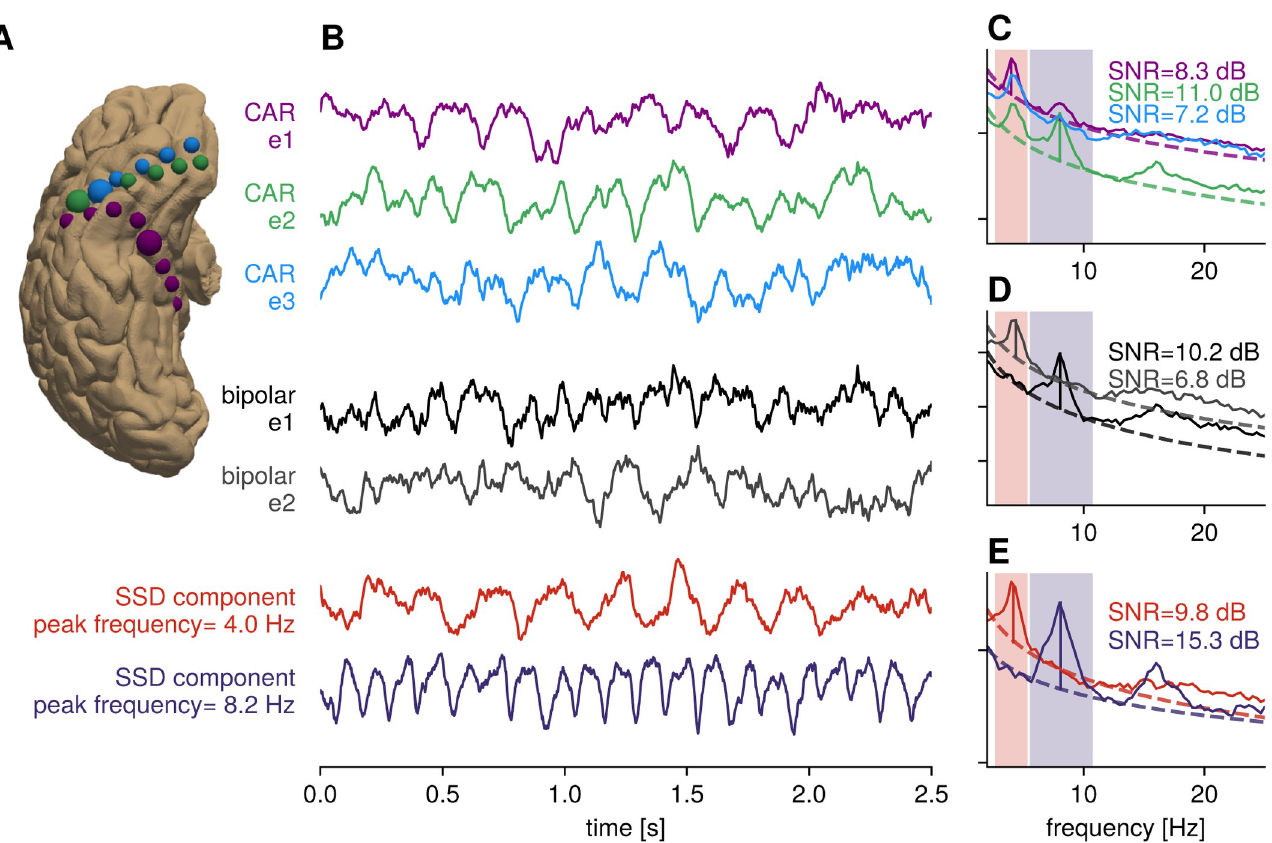
Fig 3. Illustration: Increase of relative SNR for sEEG. A) Three sEEG leads (blue, green, purple color respectively) plotted on cortical surface, ventral view. The electrodes highlighted with a larger circle size correspond to the colored traces. B) Time domain signals for common average referenced (CAR) signals, bipolar referenced signals and strongest SSD components for two selected peak frequencies, with bandwidth highlighted with colored boxes in spectral plots. C) Power spectral densities for common average referenced signals, showing multiple peak frequencies in the spectrum. D) Power spectral densities for bipolar-referenced signals. E) Power spectral densities for SSD components, showing an increased SNR over standard